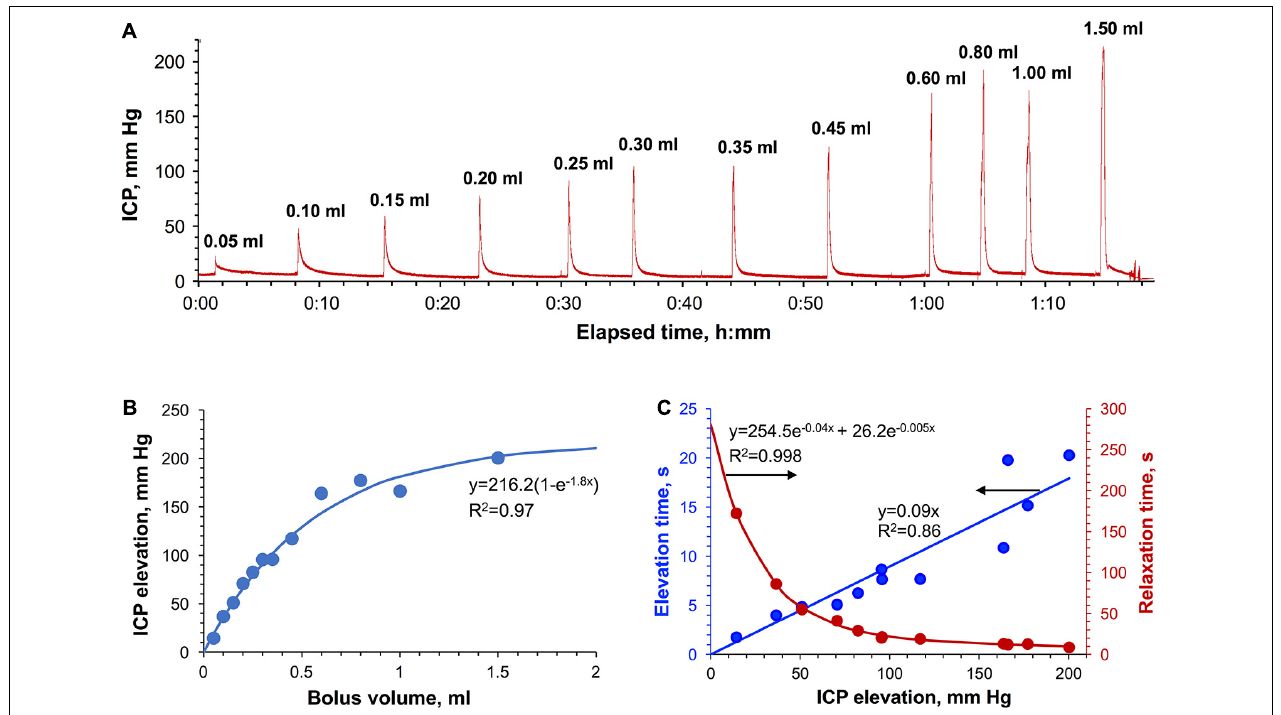
FIGURE 4 | Bolus IT injections in rats. (A) The time-dependence curve of ICP elevation. The average administration rate is 2.7 ± 0.9 ml/min. (B) Dependence of the ICP elevation on the injected volume. (C) The pressure dependence of the total ICP elevation (blue) and ICP relaxation time